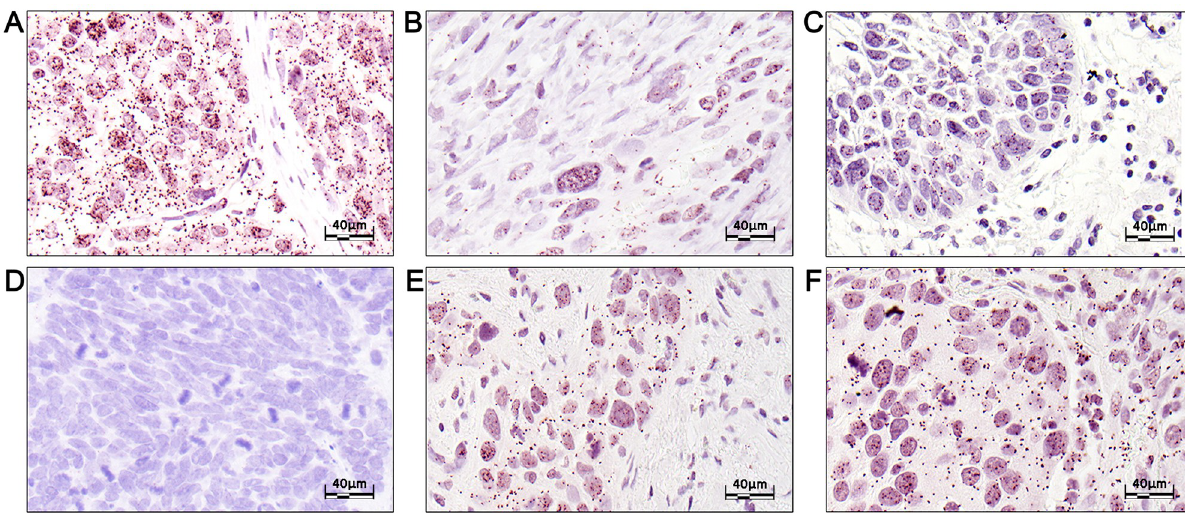
Fig 1. In situ PLA showing IGF1R/PCNA colocalization in cancer tissue. Representative photomicrographs of IGF1R/PCNA in situ proximity ligation assay (PLA) in different cancer forms. A) desmoplastic melanoma, B) malignant peripheral nerve sheath tumor, C) oropharyngeal squamous cell carcinoma, D) Merkel cell carcinoma, E) high-grade urothelial carcinoma, F) pulmonary adenocarcinoma. Strong nuclear and cytoplasmic colocalization was found in a desmoplastic melanoma (A). Sometimes, we observed more PLA signals in dysplastic cells, here represented by a malignant peripheral nerve sheath tumor (MPNST)/sarcoma (B). Varying levels of IGF1R/PCNA colocalization were found depending on the type of tumor, but it was frequently stronger in tumor cells than surrounding tumor stroma (E) or tumor infiltrating lymphocytes (C). Some cases showed no signals in the tumor cells, here represented by a Merkel cell carcinoma